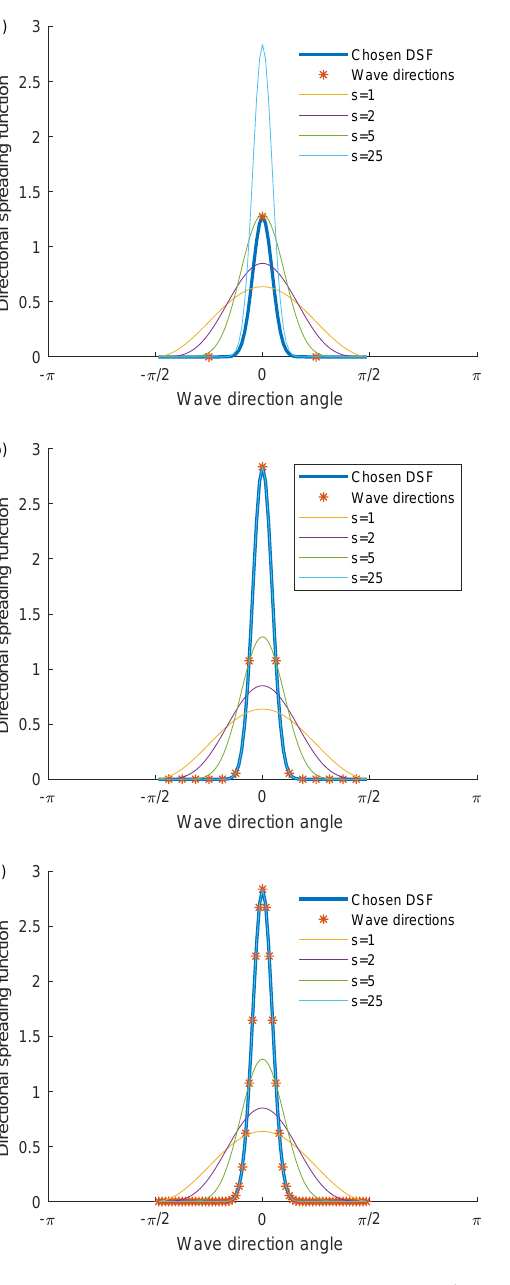
Figure 5. Directional spreading function D ( χ m − ¯ χ ) in Equation (21) for spreading parameter s = 25 increasing wave directions from 3, 15 and 63, as shown in the directional spreading function plots. A time instant of the surface elevation is shown to the right. Note that, due to the few wave directions, the magnitude of the directional spreading function defined by Equation (24) does not completely converge to the integral value in (22), but takes a smaller value. ( a ) three wave directions χ m = ± m π /4 with m = 0,1; ( b ) 15 wave directions χ m = ± m π /16 with m = 0, . . . ,7; ( c ) 63 wave directions χ m = ± m π /64 with m = 0, . . .